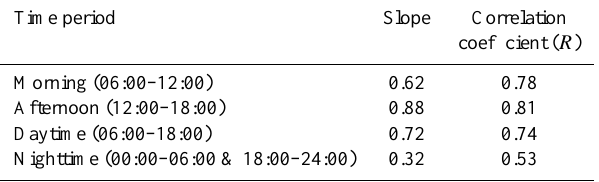
Table 2. Comparisons of the modelled and measured sulfuric acid concentrations during different time period for 12 investigated days. Slope represents the ratio between the modelled and observed sul- furic acid concentrations.